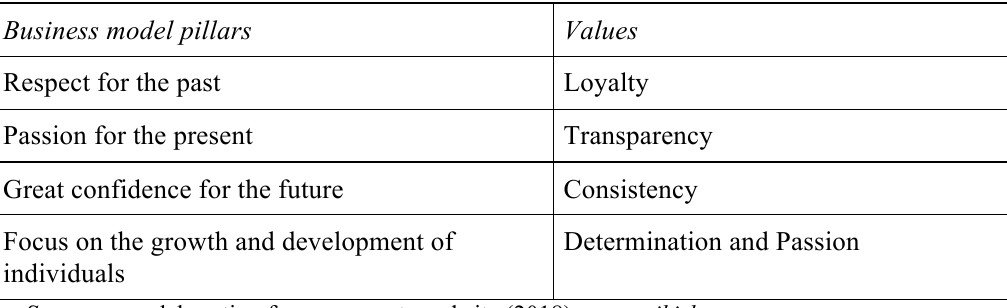
Table 2: Pillars of Geico Business